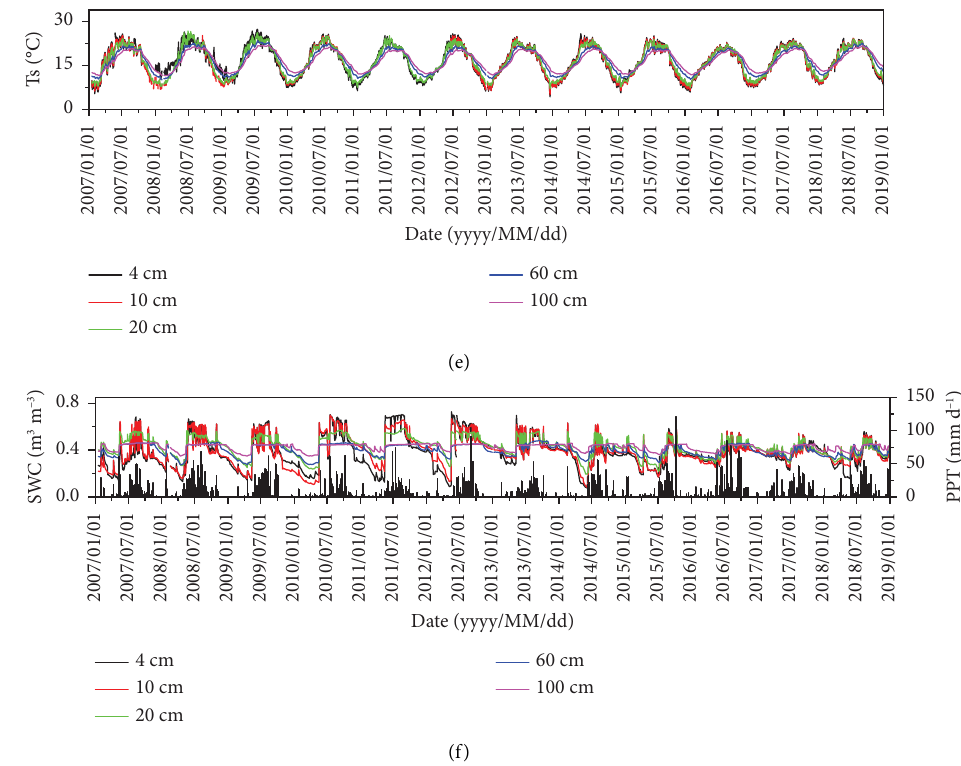
Figure 5: Daily integrated global solar radiation (Rg) (a), daily averaged air temperature (Ta) (b), relative humidity (RH) (c), and wind speed (WS) (d) at four heights, daily averaged soil temperature (Ts) at fve depths (e), and daily averaged soil water content (SWC) at fve depths and daily total precipitation (PPT) (f) from 2007 to